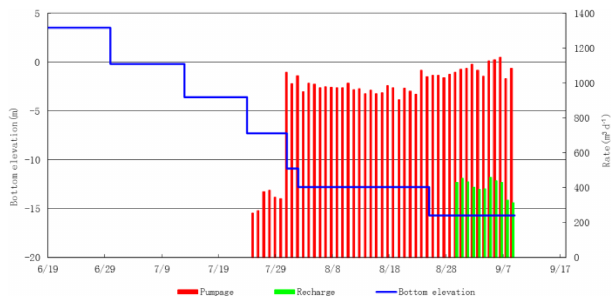
Figure 4. The observation data of the bottom elevation of the foun- dation pit, pumpage and recharge.